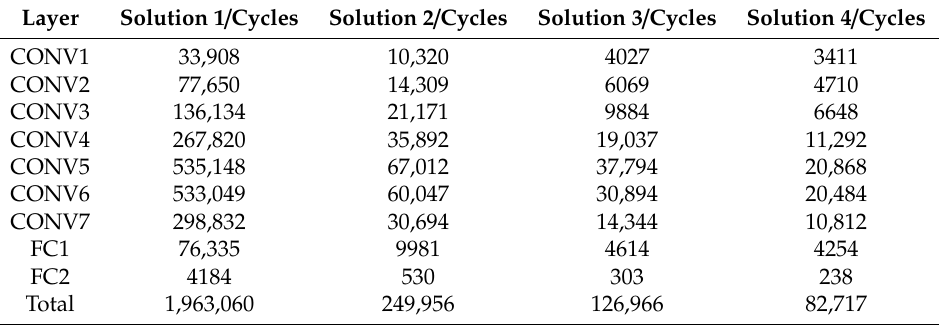
Table 2. Performance of unoptimized and optimized memory access solutions.